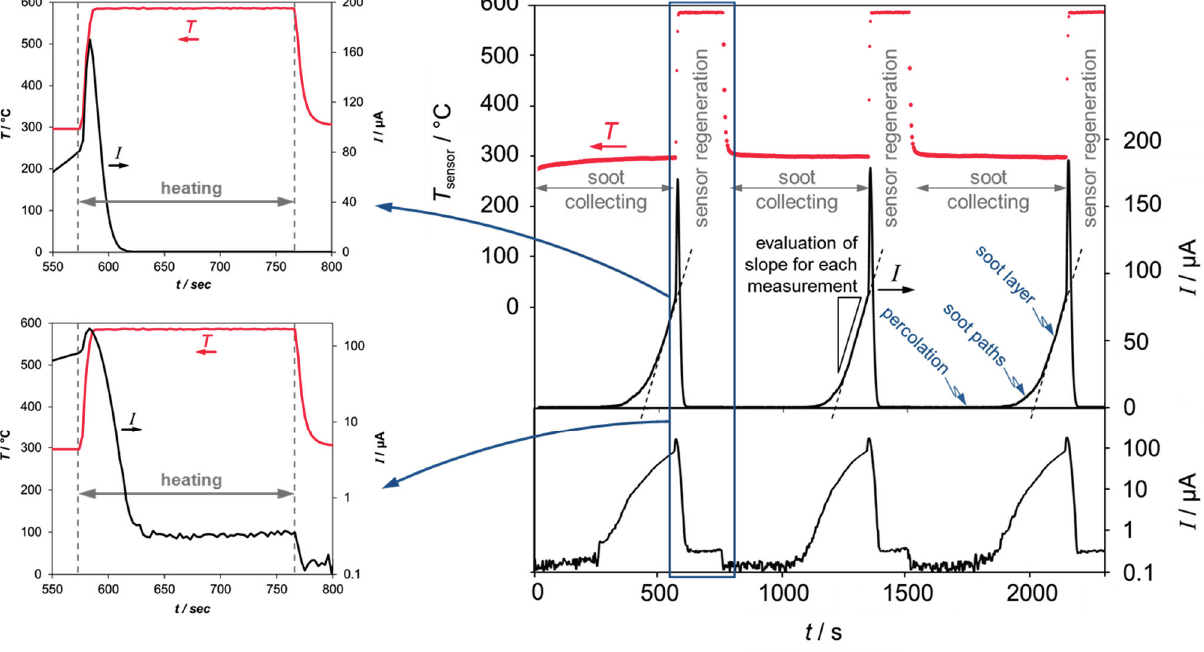
logarithmic representation. The small peak directly after heating stems from the increased soot conductivity with temperature before the soot is burned